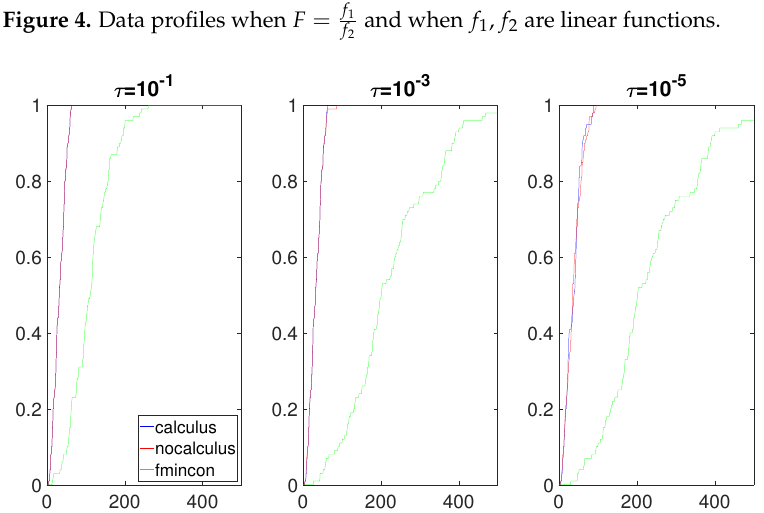
Figure 4. Data profiles when F = f 1